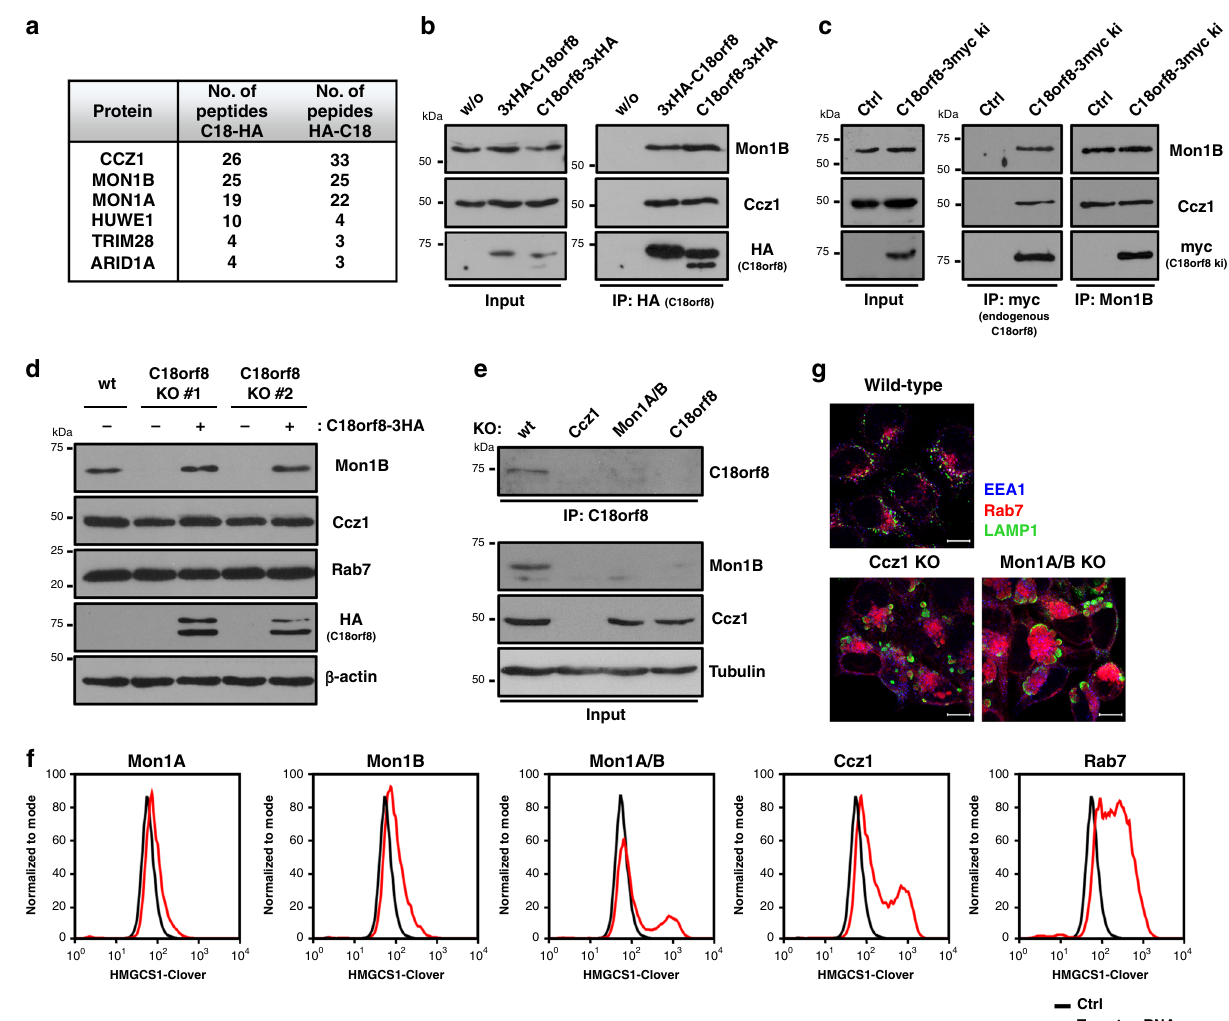
Fig. 5 C18orf8 forms an integral component of the Mon1-Ccz1 (MC1) complex, essential for complex stability and function. a – c C18orf8 interacts with the Mon1-Ccz1 complex. Immune precipitations of exogenous 3xHA-C18orf8 (N-term) or C18orf8-3xHA (C-term) were analysed by mass spectrometry ( a ) or Western blotting using Mon1B-, Ccz1- and HA-speci fi c antibodies ( b ). Proteins detected by >3 peptides in both C18orf8 samples and absent from control, are indicated in a . Full MS results are available in Supplementary Data 2 and via ProteomeXchange with identi fi er PXD021444. c Immune precipitation of an endogenous C18orf8-3xMyc fusion or Mon1B reveals a reciprocal interaction between endogenous C18orf8, Ccz1 and Mon1B (see also Supplementary Fig. 5c). d , e C18orf8, Mon1B and Ccz1 show reciprocal stabilisation. Immunoblot analysis of lysates from ( d ) wild-type, C18orf8 -de fi cient and C18orf8 -de fi cient cells complemented with C18orf8-3xHA (3 independent experimental replicates); or ( e ) wild-type, C18orf8- , Ccz1 - and Mon1A/B - de fi cient cells. For endogenous C18orf8 detection, C18orf8 was immune precipitated prior to immunoblotting ( e ). f , g Ccz1 - and Mon1A/B -de fi cient cells show cholesterol de fi ciency and disruption of LE/Ly morphology. f HMGCS1-Clover CAS9 cells (black lines) were transfected with sgRNAs against Mon1A , Mon1B , Mon1A and Mon1B , Ccz1 or Rab7 (red lines) or control (black lines), grown for 14 days, treated overnight with mevastatin and analysed for HMGCS1- Clover expression. g Wild-type, Ccz1 - and Mon1A/B -de fi cient cells were stained intracellularly for EEA1 (blue), Rab7 (red) and LAMP1 (green). Representative images are shown from fi ve fi elds per condition. Scale bars = 10 µ The robust interaction of C18orf8 with all three MC1 C18orf8 stability depends on Mon1A/B and Ccz1, whereas Ccz1 components suggests C18orf8 is either a regulator or integral remains relatively stable in the absence of both other components component of the mammalian MC1 complex. Interestingly, while (Fig. 5e). We conclude that mammalian Mon1, Ccz1 and C18orf8 C18orf8 -de fi cient cells expressed normal levels of Ccz1, they form a stable trimeric complex, the MCC complex, of which C18orf8 is a core component. showed a marked reduction in Mon1B expression (Fig. 5d), C18orf8 , Ccz1 and Rab7 are all prominent hits in our screens which was restored by re-expression of full-length C18orf8 (Fig. 1g, Supplementary Fig. 2b). To determine whether the (Fig. 5d), its C-terminal MC1-interaction domain (Supplemen- function of C18orf8 overlaps with mammalian MC1, we tary Fig. 5e) or proteasome inhibition (Supplementary Fig. 5f). knocked-out Ccz1 , Mon1A , Mon1B and Rab7 in our HMGCS1- Mon1B expression was also decreased in Ccz1 -de fi cient cells, Clover reporter line. Similar to C18orf8 depletion, loss of Ccz1 or a combination of Mon1A and Mon1B — but neither alone — increased HMGCS1-Clover expression, as did knockout of the stability is therefore dependent on C18orf8 and Ccz1 and in the Rab7 GTPase (Fig. 5f). This phenotype was restored by